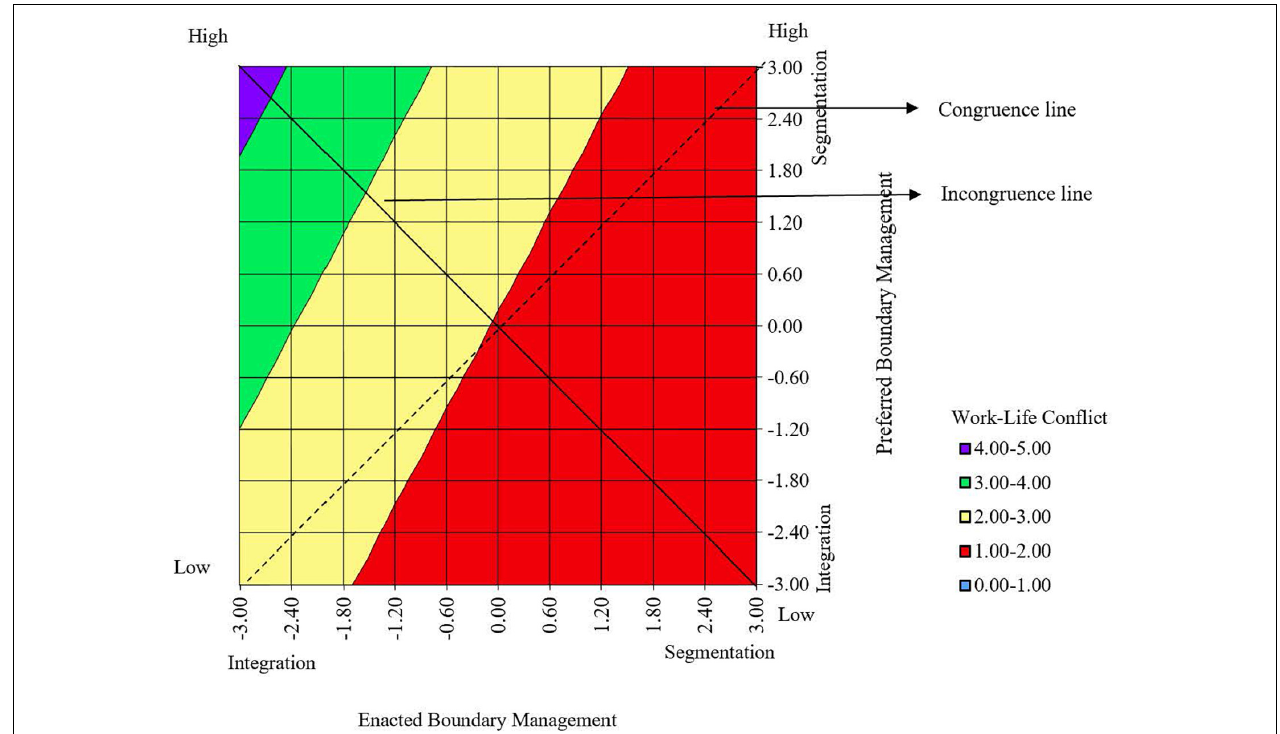
FIGURE 1 | Graphical aid for interpreting congruence and incongruence lines in the response surface.